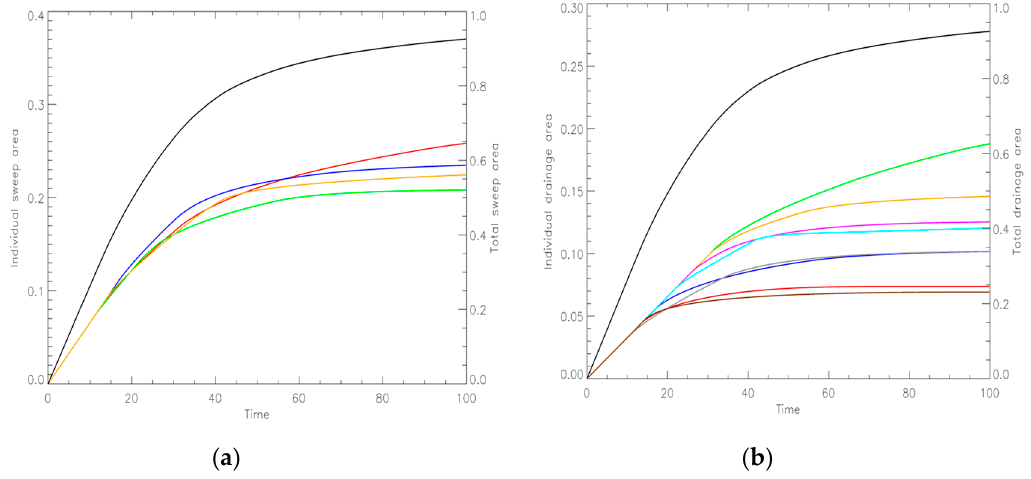
Figure 5. CAM simulations. ( a ) Sweep area versus non-dimensional time attributed to individual injectors (percentage of total sweep area, left scale) and for all injectors combined (total sweep area, right scale). ( b ) Drainage area versus non-dimensional time attributed to individual producers (percentage of total drainage area, left scale) and for all producers combined (total drainage area, right scale). Reproduced with permission from [3].